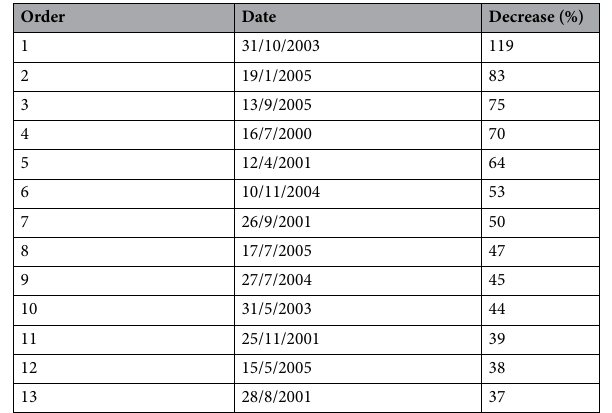
Table 1. The 13 most influential FD events since 2000 during which the CERES and MODIS instruments have been active, sorted by strength. The first and second columns are, respectively, the order and date of minimum cosmic ray flux. The third column shows the percentage decrease in the ion production relative to the reduction in cosmic rays from solar minimum to solar maximum over a solar cycle, i.e., FD 1 changed the GCR flux more than the average change over the solar cycle 23 .Note that while there have been several FDs since the latest on the list (Sept. 13th 2005) none of them have been strong enough to enter the top 5 of the